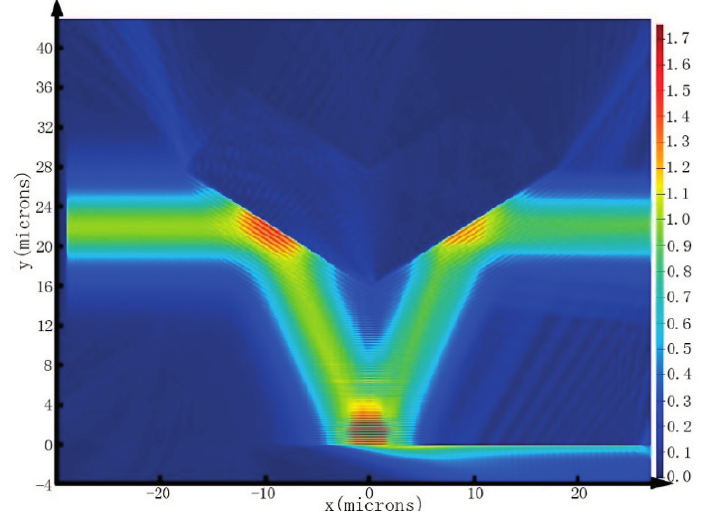
Figure 11. The electric intensity map of the bimetallic SPR sensor with 3 nm Au over 32 nm Al in the 2D-FDTD simulation at an operating wavelength of 1550 nm. The mesh grid in the regions of trench-based waveguide bends is set to 5 nm, and the mesh grid of metal layer is set to 1